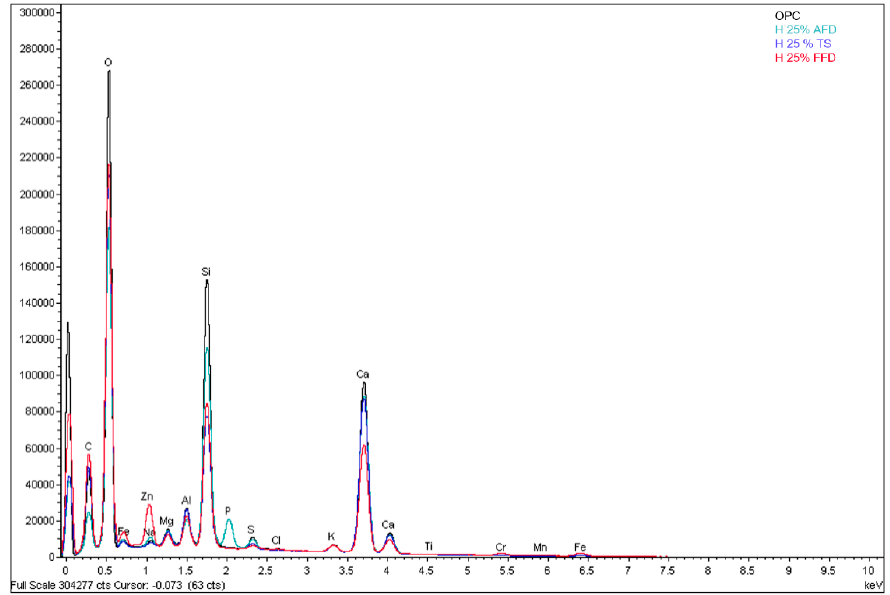
Figure 12. EDS spectra obtained from the surface of OPC, AFD, FFD, and TS mortar samples.